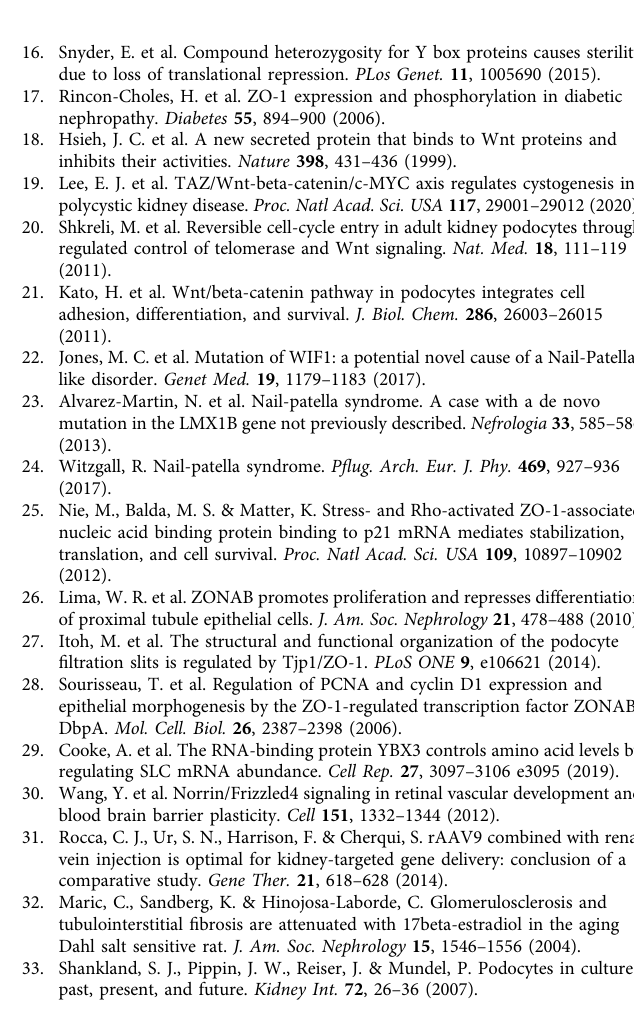
Fig. 8 Regulation of Wif1 expression by CLDN5. a Co-IP of CLDN5, ZO1, and ZONAB in multiply transfected HEK293 to determine CLDN5 and ZO1/ ZONAB interaction. b Co-IP showing that endogenous CLDN5 interacts with endogenous ZO1/ZONAB in isolated mouse glomerulus. Antibodies used for immunoprecipitation are shown above the lanes; antibody for blot visualization is shown on the left. c Double immunostaining for ZO1/ZONAB and ZO1/ CLDN5 in primary podocytes plated on coverslips. d ZO1 immunostaining in kidney sections from WT and Cldn5 KO mice. e Double immunostaining for ZONAB and WT1 in kidney sections from WT and Cldn5 KO mice. f Western blotting for ZONAB expression in the glomerulus of WT and Cldn5 KO mice. Glomerulus were isolated from WT and Cldn5 KO mice followed by fractionation. The levels of ZONAB were analyzed by western blotting, with GAPDH, β - tubulin, Nephrin, and Histone H3 serving as controls for the purity of the cytosolic fraction (C), cytoskeletal fraction (CS), membrane fraction (M), and nuclear fraction (N), respectively. g Expression levels for Wif1 mRNA in Cldn5 KO primary podocytes transfected with empty vector pcDNA3 (CTL), expression vector for Zo1, or co-transfected with expression vector for Zo1 and Cldn5 ( n = 5 independent experiments, * P < 0.05). h , i Renilla/ fi re fl y luciferase activity ratios in MDCK ( h ) and primary mouse podocytes ( i ) transfected with Wif1:3 ′ -UTR and empty vector pCMV6 (CTL), pCMV6-Zonab-V1, or pCMV6-Zonab-V2 ( n = 5 independent experiments, **** P < 0.0001). j Effects of transfection with an siRNA targeting Zonab (Zonab KD) on Wif1 gene expression in primary podocytes from Cldn5 KO mice ( n = 5 independent experiments, *** P < 0.001). k , l Association of endogenous ZONAB with endogenous Wif1 mRNA as measured by RIP and qRT-PCR analysis using either an anti-ZONAB antibody or control IgG ( k ). The values are the means ± SEM from triplicate samples, *** P < 0.001 compared with IgG IP. ZONAB protein levels were analyzed by western blotting to ensure ef fi cient pull- down ( l ). m Levels of the Wif1 mRNA at different times after administration of actinomycin D ( n = 5 independent experiments, * P < 0.05, ** P < 0.01). Nuclei were visualized by DAPI. Scale bar, 20 μ m. Data are presented as mean values± SEM. Two-tailed unpaired Student ’ s t test was used for statistical comparisons ( g – k and m ). Source data are provided as a Source data